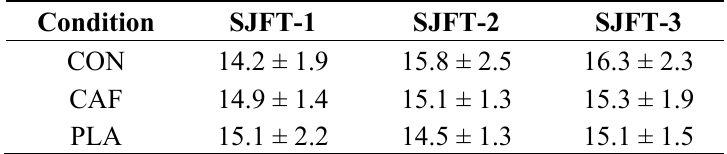
Table 4. Performance index during the SJFT for caffeine (CAF), placebo (PLA) and control (CON) conditions (Mean ±